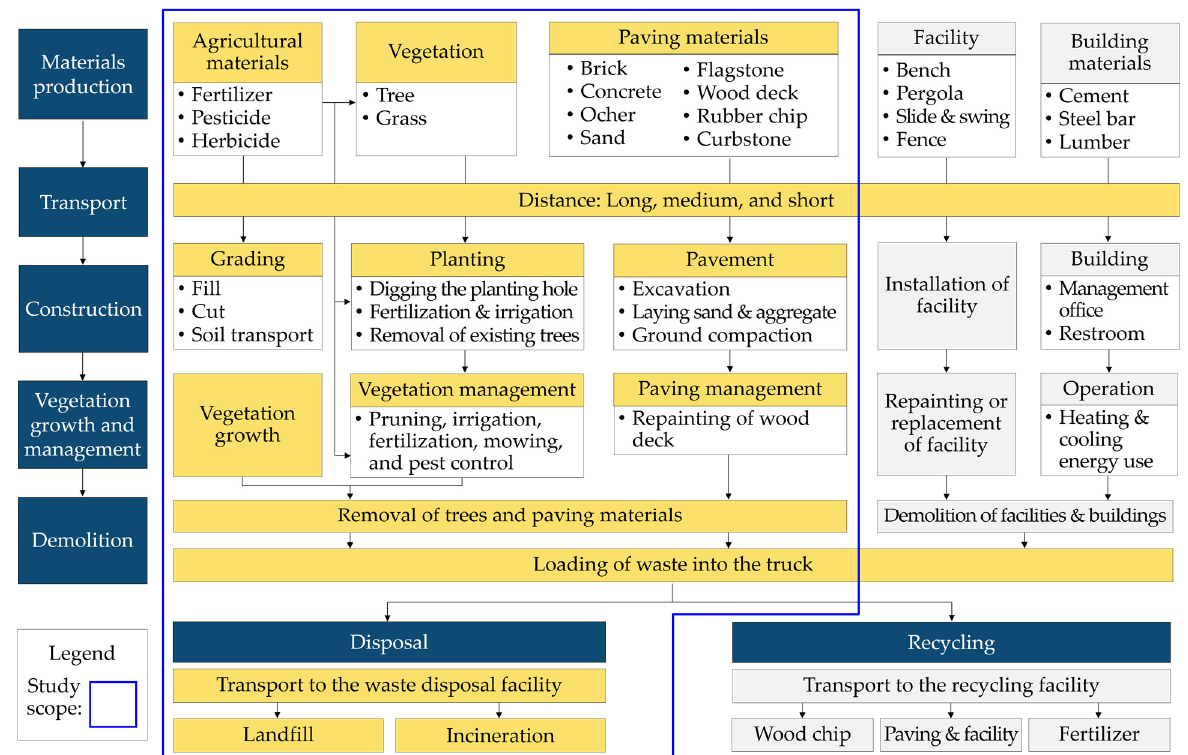
Figure 2. Life cycle assessment scope of study parks.